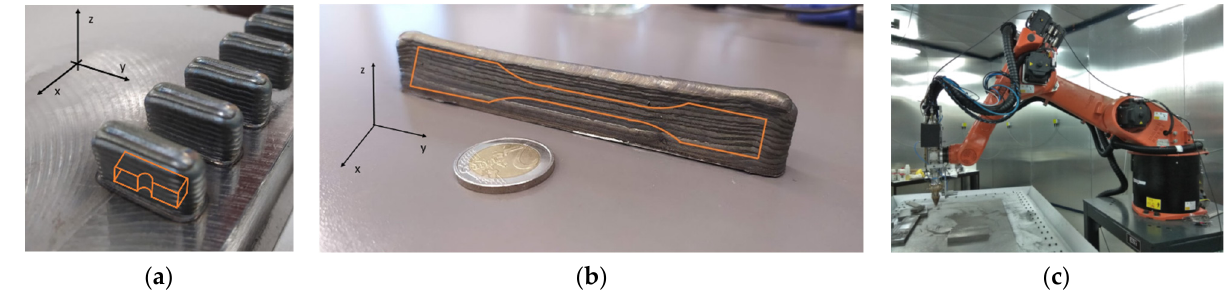
Figure 1. Samples manufacturing process: ( a ) Miniature specimen orientation; ( b ) Tensile specimen orientation [17]; ( c ) DED system [17].